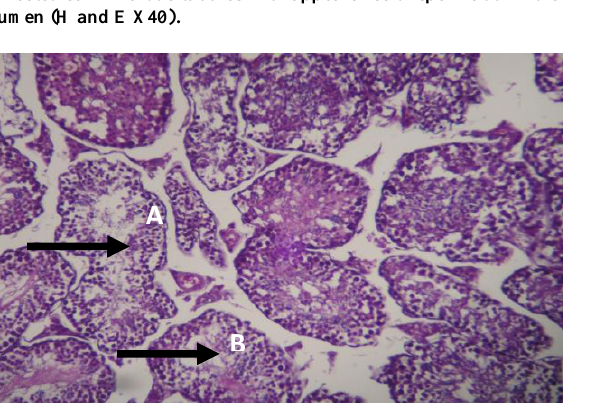
Figure, 4: Histological section in testis of mice given D.W. shows normal seminiferous tubules with appearance of spermatid (A) and sperms (B) in the lumen (H and E